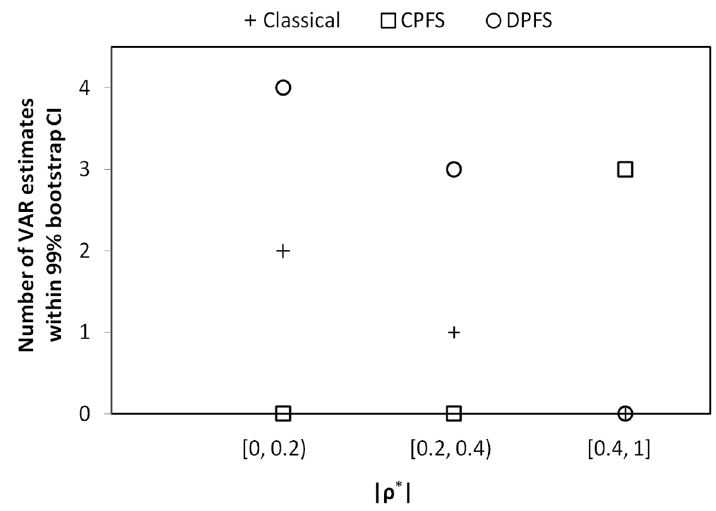
Figure 12. The number of instances when VaR estimation is within 99% bootstrap confidence interval (CI) is plotted versus the magnitude of the correlation ( | ρ ∗ | ) between loss severity and loss frequency for the three methods; namely, classical, CPFS and DPFS. The number of instances is counted using both simulated and real-world datasets. Examining through all of the data sets, we observe three instances where the CPFS methodology accurately estimates the VaR for all of the upper quantiles of the VaR estimate, namely, 90%, 95%, 98%, 99%, 99.5% and 99.9%. Overall, for | ρ ∗ | ≳ 40%, the CPFS methodology is the best choice for VaR estimation.